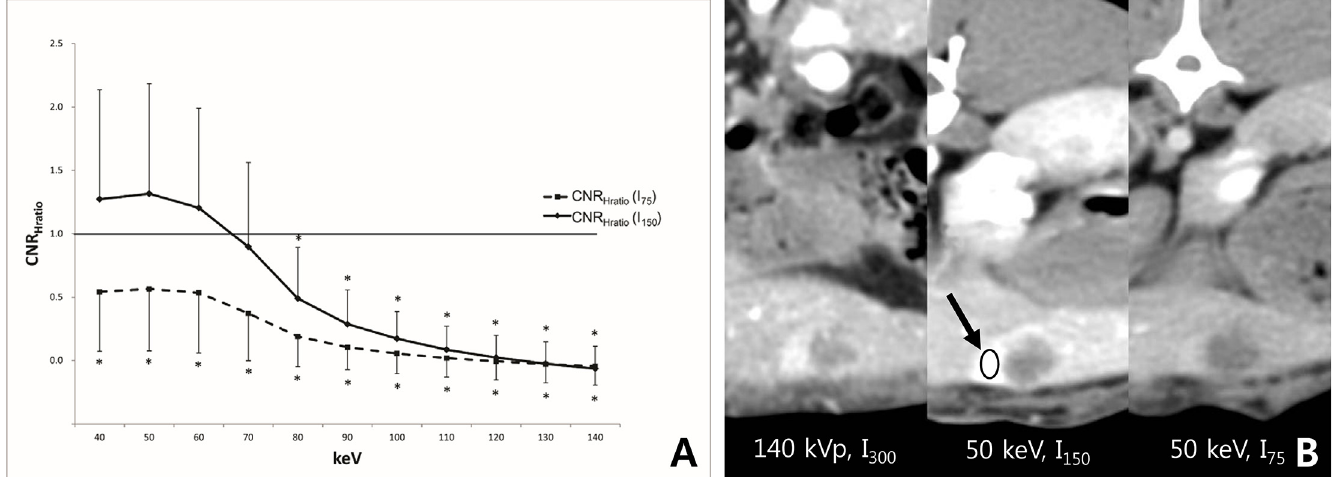
Fig 4. (a) The mean CNR Hratio with I 150 was not different from 1 between 40keV and 70 keV, whereas, the mean CNR ratio with I 75 was significantly lower than 1 for the entire keV range of monoenergetic images. (b) Compared to the CNR H of 140 kVp with I 300 , the CNR H was higher in the 50 keV image with I 150 (CNR Hratio = 1.2), whereas the CHR H was lower in the 50 keV image with I 75 (CNR Hratio = 0.2). Note. — * , CNR Hratio was significantly lower than 1; arrow, and the region of interest was drawn in the hypervascular portion of the VX2 tumor.